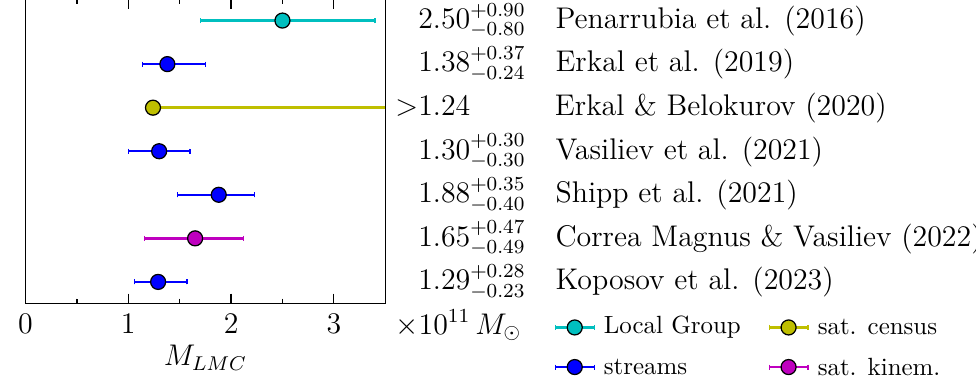
Figure 1. LMC mass estimates from different methods: blue—perturbations inflicted on stellar streams; cyan—momentum balance in the Local Group; yellow—census of LMC satellites; magenta— kinematics of Milky Way satellites. From top to bottom: Peñarrubia et al. [32], Erkal et al. [33], Erkal and Belokurov [34], Vasiliev et al. [35], Shipp et al. [36], Correa Magnus and Vasiliev [37], Koposov et al.